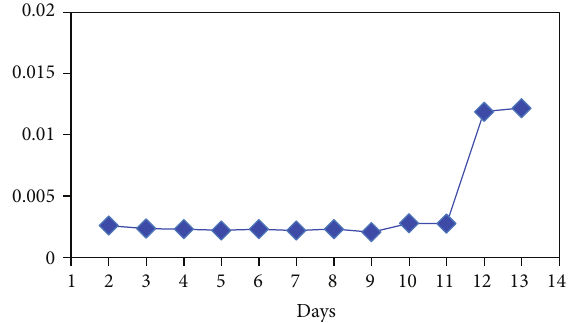
Figure 16: 𝐾 factor value during the test for all